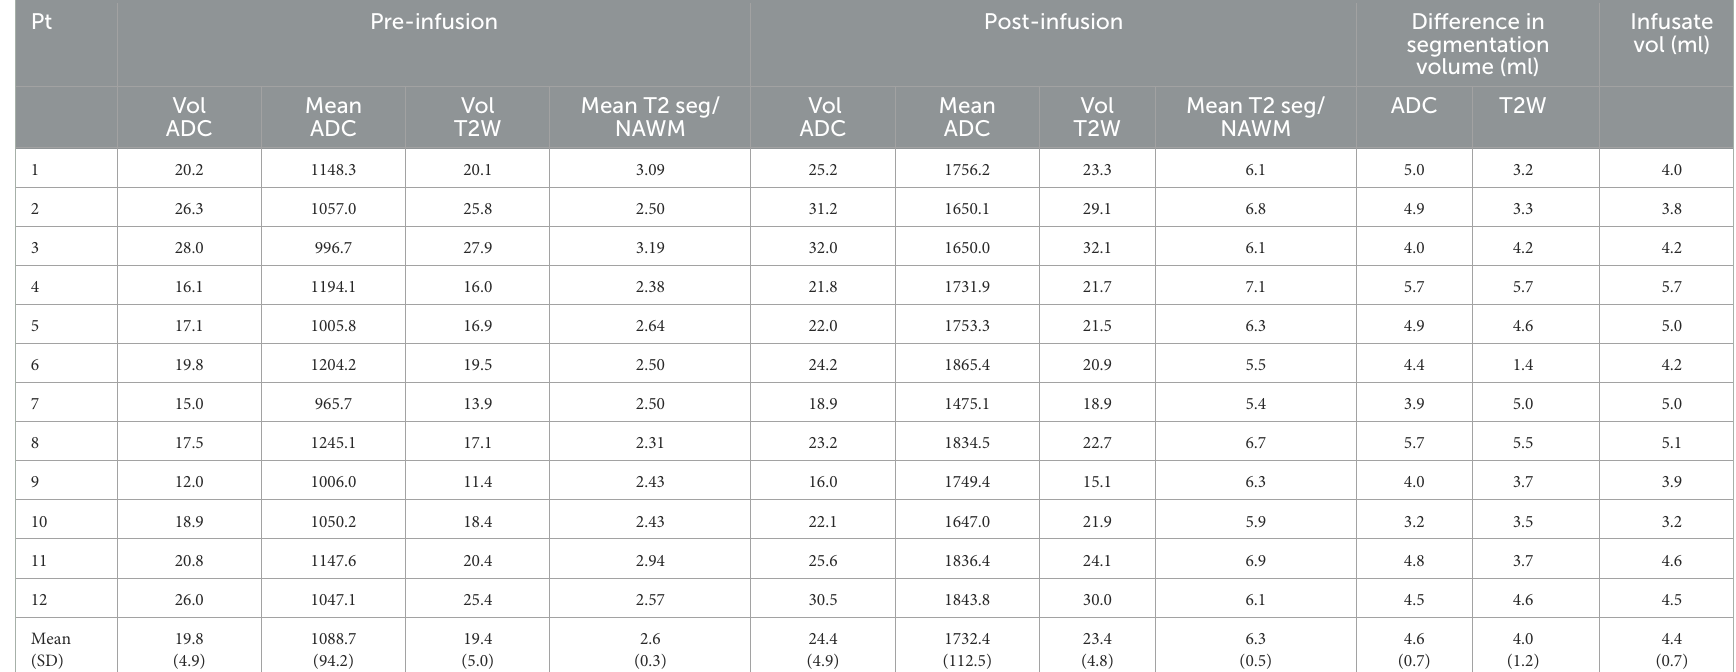
TABLE 3 Pre and post infusion difference in MRI